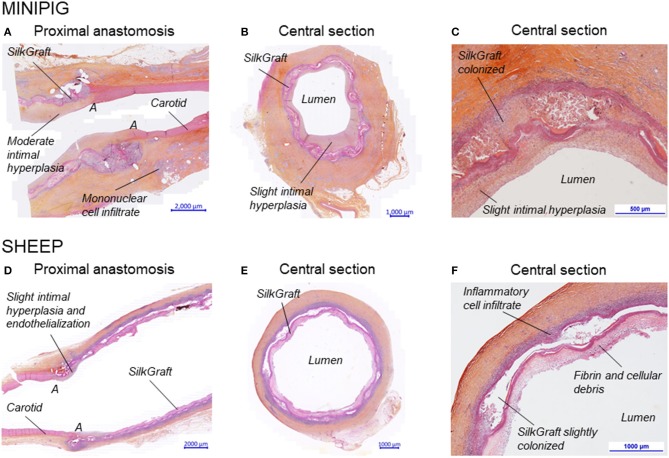
Histopathogical analysis of a SilkGraft stitched end-to-end on the carotid artery of minipig and sheep 4 weeks after grafting. Staining: Safranin-Hematoxylin-Eosin. Minipig: (A) Longitudinal cut in correspondence of the proximal anastomosis showing a pervious lumen (A, anastomotic line). (B) Representative cross-sectional cut of the central part of the graft. The lumen is pervious, though moderately reduced by an intimal hyperplasia. (C) Detail of the graft wall: perivascular cell infiltrates are visible; the inner and outer ES layers appear compact, whereas the TEX layer is penetrated by growing vessels and collagen-producing fibroblasts; endothelialization is visible at the inner graft surface. Sheep: (D) Typical longitudinal sections of the proximal end-to-end anastomotic sites (A, anastomotic line); the lumen is pervious and devoid of any stenosis. Endothelization is restricted to a 3 mm-wide area beyond the anastomosis. (E) Representative cross-section of the central part of the graft; the lumen is pervious while endothelization, neointimal hyperplasia, and stenosis are absent. (F) Detail of the graft wall: an inflammatory infiltrate envelops the graft; a newly-formed vascularized connective tissue only partly colonizes the middle TEX layer.